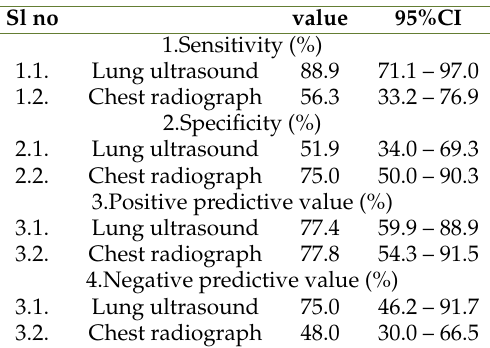
Table 1. Comparison of various features of lung ultrasound and chest radiograph